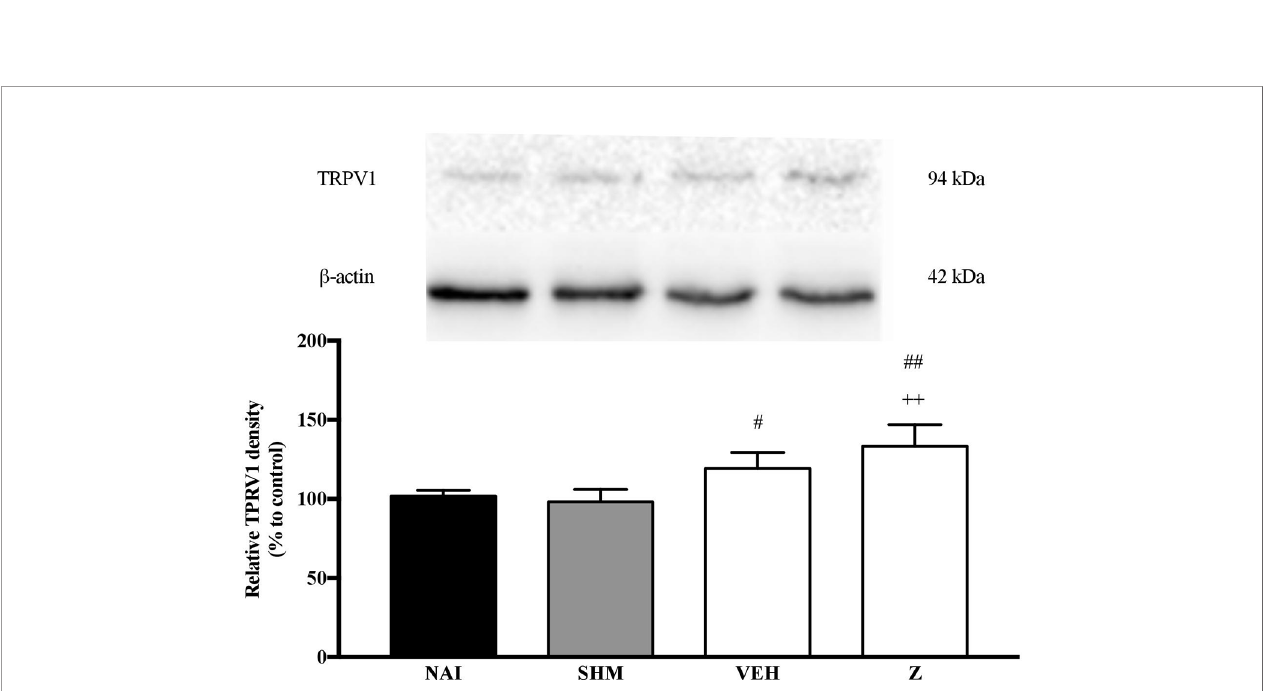
FIGURE 10 | Representative western blots of TRPV1 receptor from brain samples of naïve, sham, vehicle and zerumbone-treated groups. Data presented as mean ± SEM (n = 4), which were normalized to b -actin. ++ p < 0.01 as compared to naïve and # p < 0.05, ## p < 0.01 as compared to sham group. NAI (Naïve); SHM (Sham); VEH (Vehicle, 10 mL/kg); Z (Zerumbone, 10